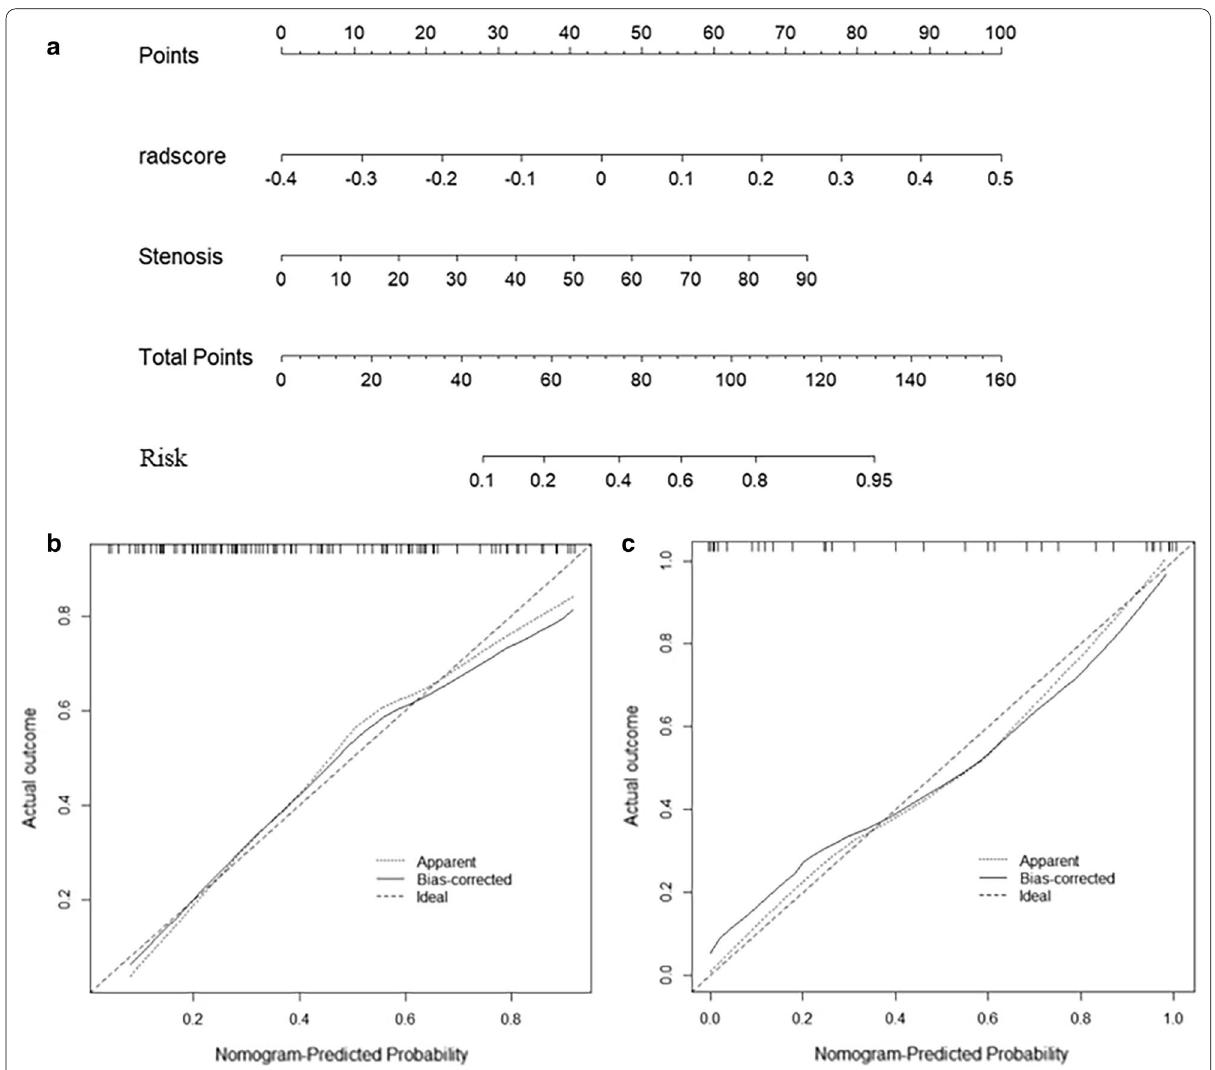
Fig. 3 The radiomics nomogram and calibration curves for the radiomics nomogram. a The radiomics nomogram, combining stenosis and Rad-score, developed in the training set. Calibration curves for the radiomics nomogram in the training ( b ) and external test sets ( c ). Calibration curve indicates the goodness-fit for the nomogram. The 45° dotted line represents an ideal prediction, and the other dotted line represents the predictive performance of the nomogram. A closer distance between two lines indicates better prediction. The solid line represents the bias corrected